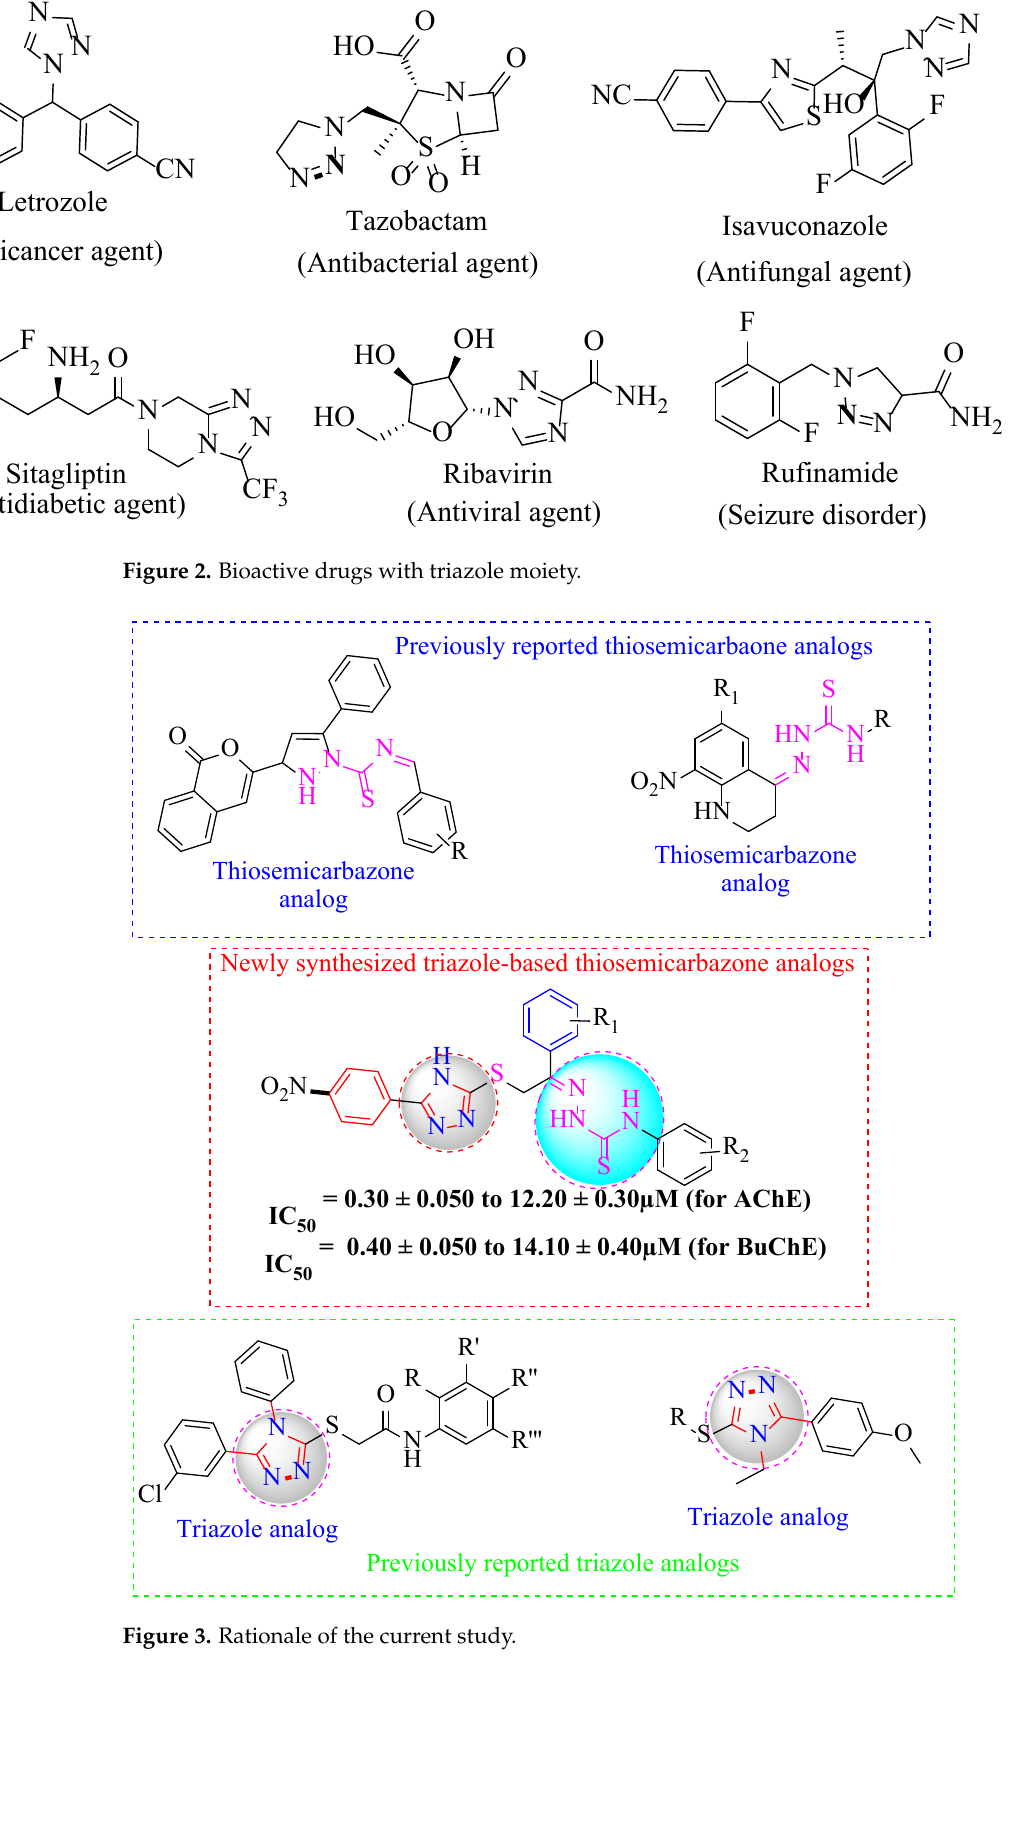
Figure 2. Bioactive drugs with triazole moiety.